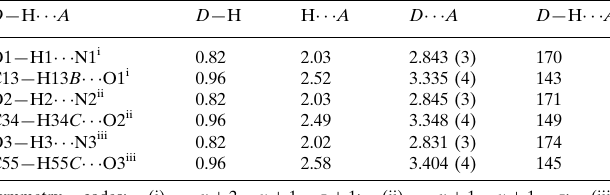
Hydrogen-bond geometry (A˚ , (cid:2)